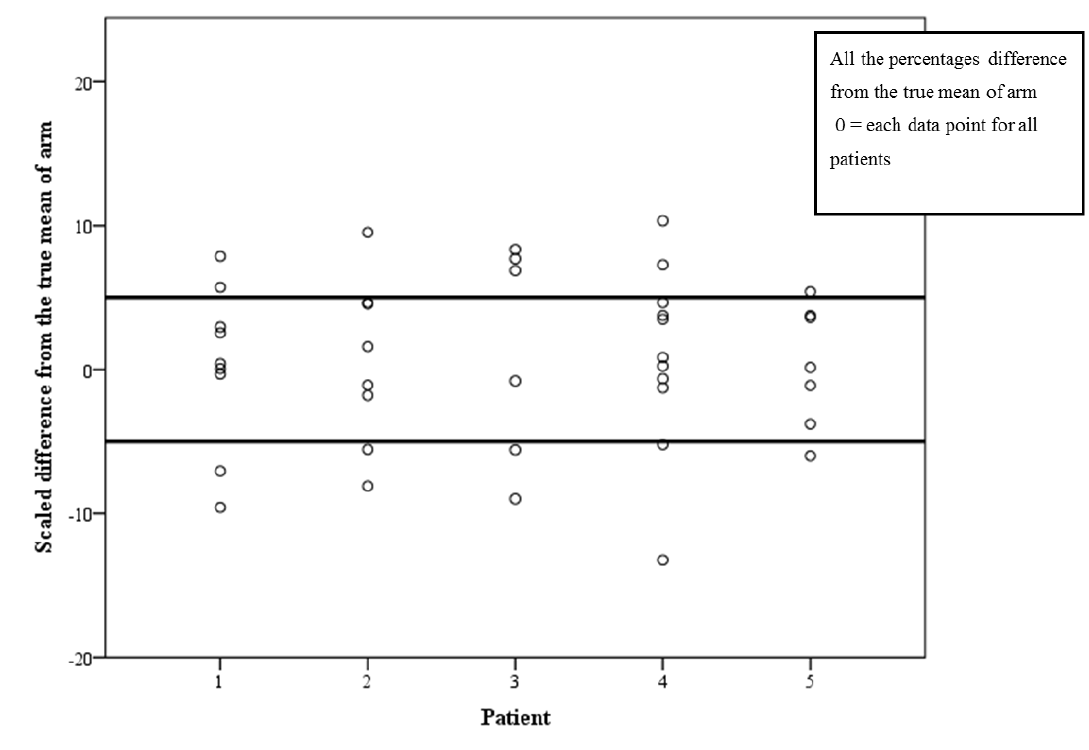
Figure 5. Scaled difference from the true mean of arm measurements for each PT with cutoff points at ± 5%.